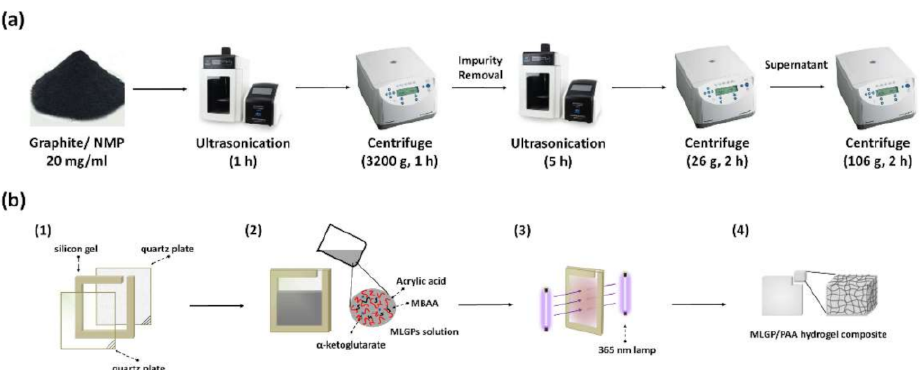
Figure 1. ( a ) Liquid-based direct exfoliation method to fabricate MLGPs. ( b ) Synthesis of MLGP/ PAA